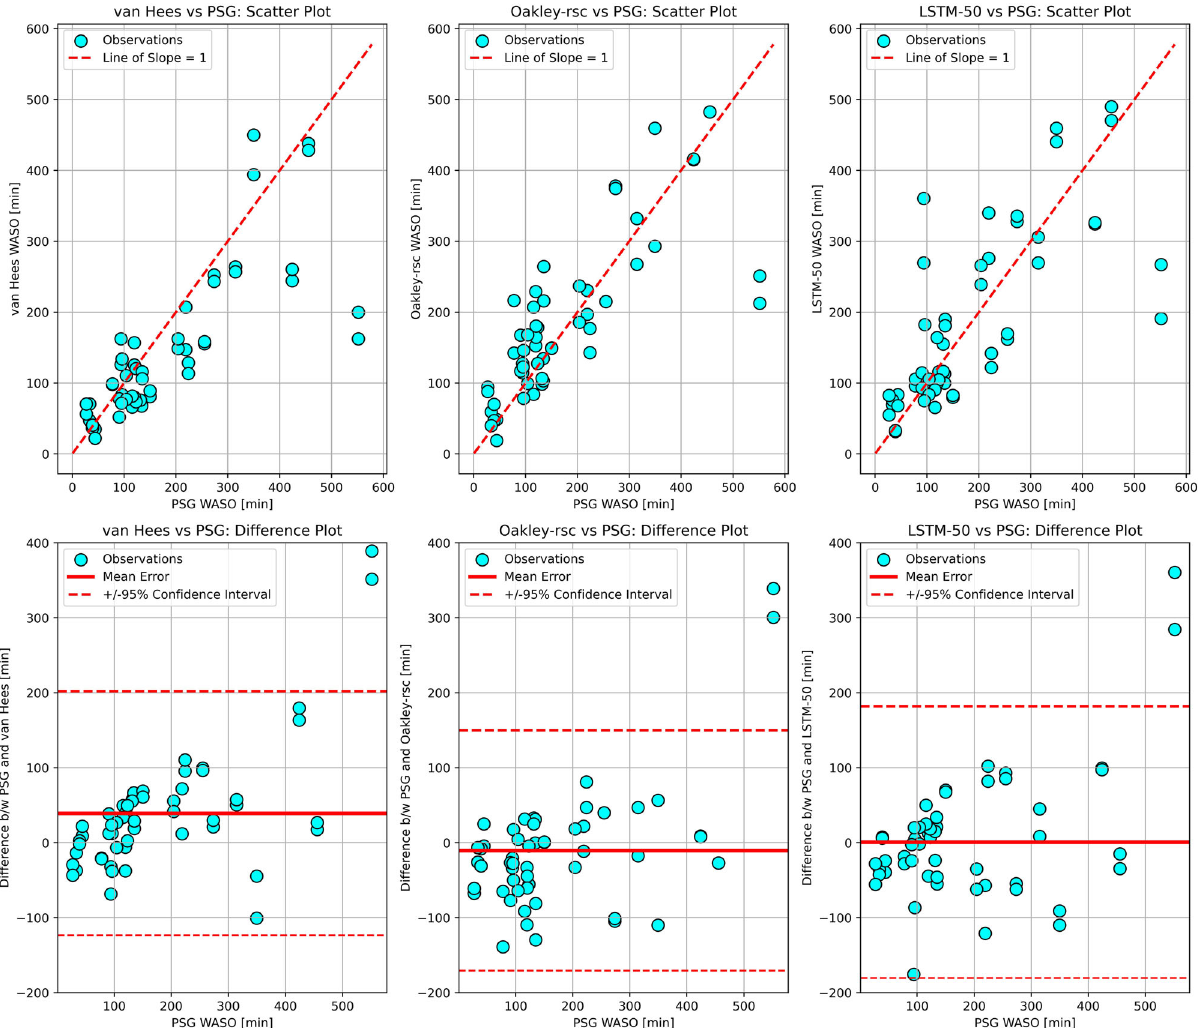
Fig. 2 Bland-Altman validation plots for estimated WASO from the top performing algorithms in each category compared to PSG. The upper plots show the comparison of each algorithm estimated WASO to PSG WASO in circles, with a dashed line of slope equal to one representing where points would fall if the algorithm and PSG matched perfectly. The lower plots show the PSG WASO plotted against the difference between the algorithm and PSG for each data point. The solid horizontal line represents the mean error and the dashed horizontal lines represent the 95% con fi dence intervals of the